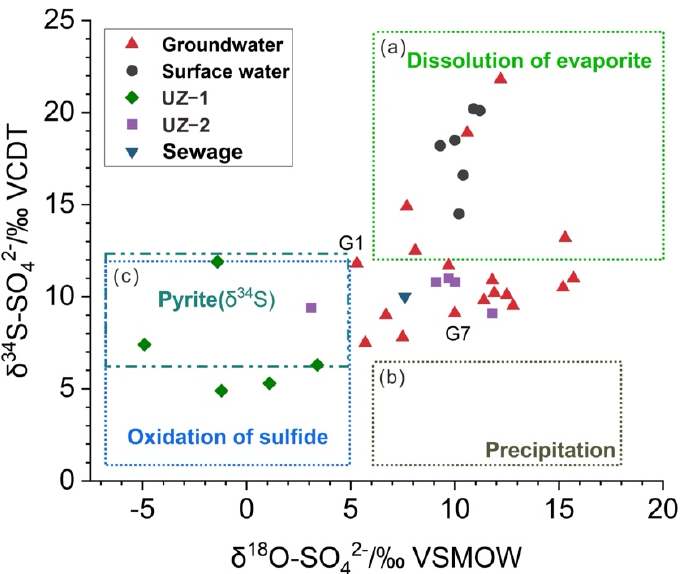
Figure 5. Compositions of δ 34 S − SO 42 − and δ 18 O − SO 42 − in the study area. The typical values of δ 34 S − SO 42 − and δ 18 O − SO 42 − for ( a ) dissolution of evaporites ranged from δ 34 S − SO 42 − = +12‰ to +35‰, δ 18 O − SO 42 − = +6‰ to +20‰; ( b ) atmospheric precipitation ranged from δ 34 S − SO 42 − = − 5‰ to +6‰, δ 18 O − SO 42 − = +6‰ to +18‰; and ( c ) oxidation of sulfide ranged from δ 34 S − SO 42 − = − 18‰ to +12‰, δ 18 O − SO 42 − = − 5‰ to +5‰ [21,56,57].